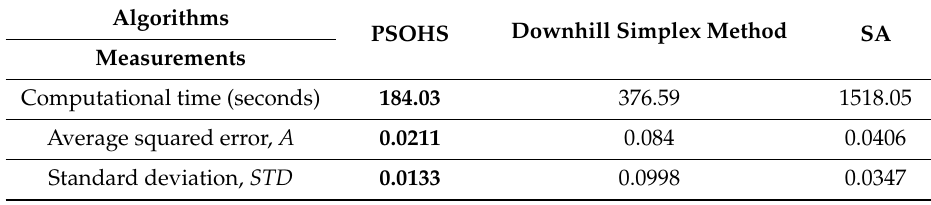
Table 3. Comparison between the performance of PSOHS, downhill simplex method, and SA in estimating nine parameters for lysine in terms of computational time, average squared error, and standard deviation.